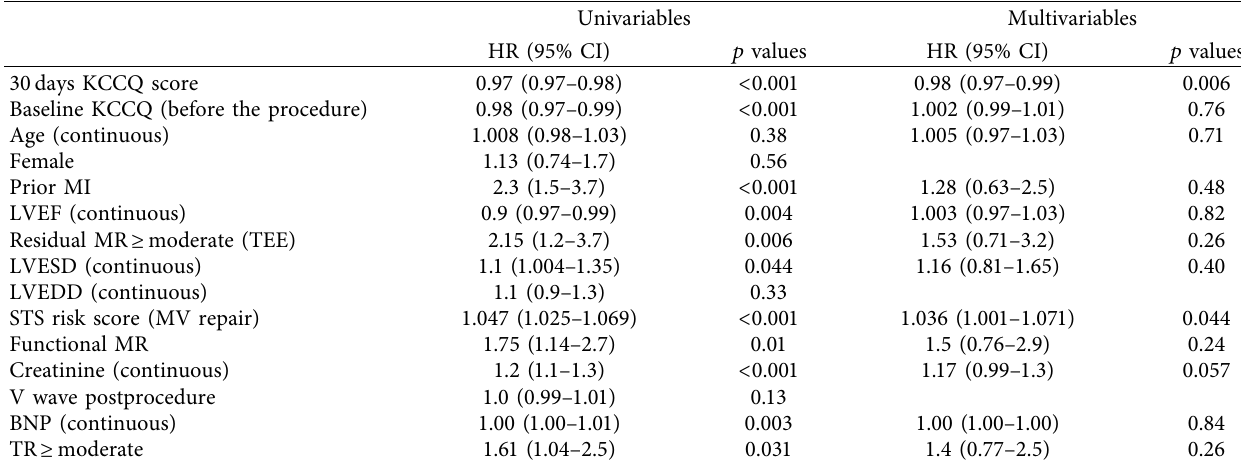
Table 3: Univariable and multivariable cox regression analyses for the primary outcome at 1 year.